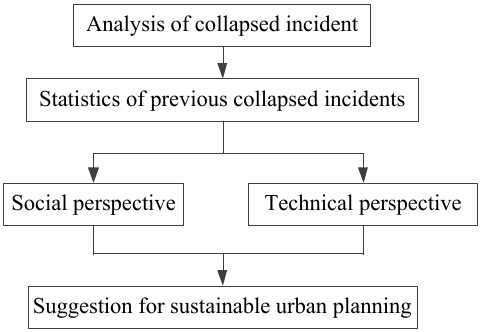
Figure 3. Procedure for the analysis of the collapsed incident.